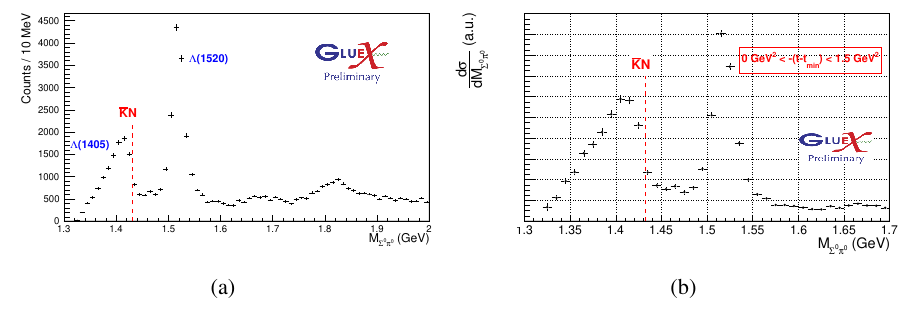
K + Σ 0 π 0 events and (b) → in the lower-mass region shown without a numerical π 0